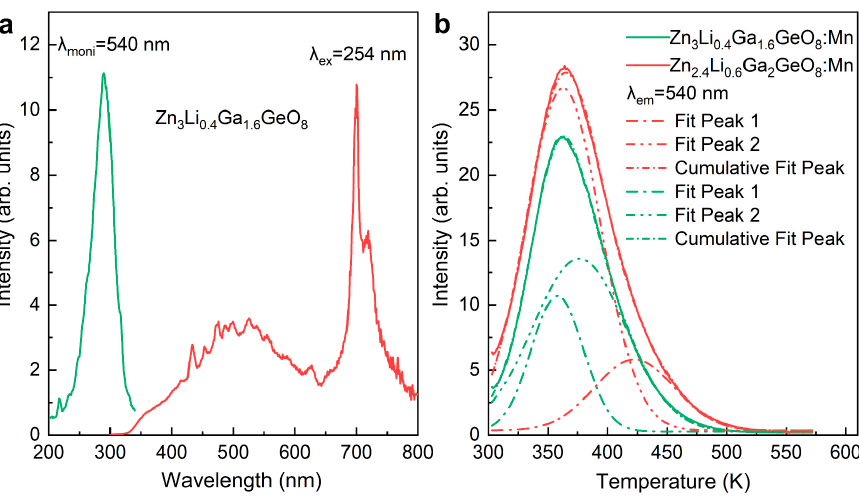
Figure 6. ( a ) PL (excitation at 254 nm) and PLE (monitoring at 540 nm) spectra of undoped Zn 3 Li 0.4 Ga 1.6 GeO 8 phosphors synthesized by hydrothermal approach; ( b ) TL spectra obtained after 5 min illumination for Zn 3 Li 0.4 Ga 1.6 GeO 8 :Mn (green curve) and Zn 2.4 Li 0.6 Ga 2 GeO 8 :Mn phosphors (red curve) prepared by hydrothermal method.